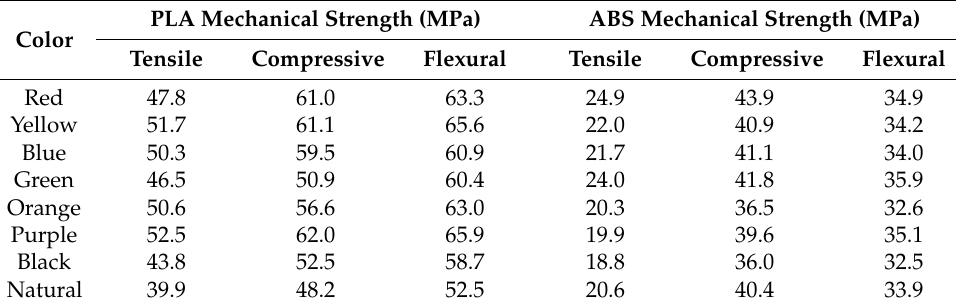
Figure 6. Mechanical strengths for PLA and ABS: ( a ) tensile, ( b ) compressive and ( c ) flexural. Table 2. Average mechanical strengths of samples in different